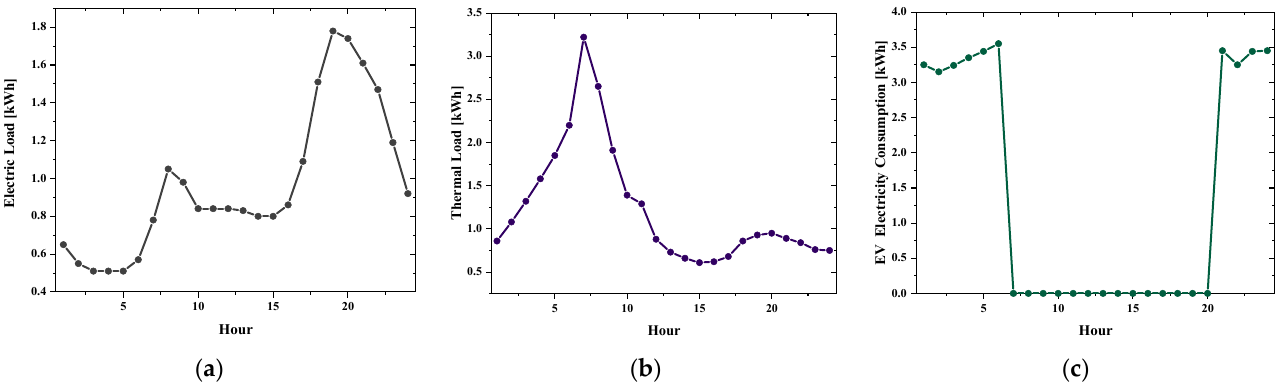
Figure 6. Yearly values of different types of load demand: ( a ) electric load; ( b ) thermal load; ( c ) EV electricity consumption.